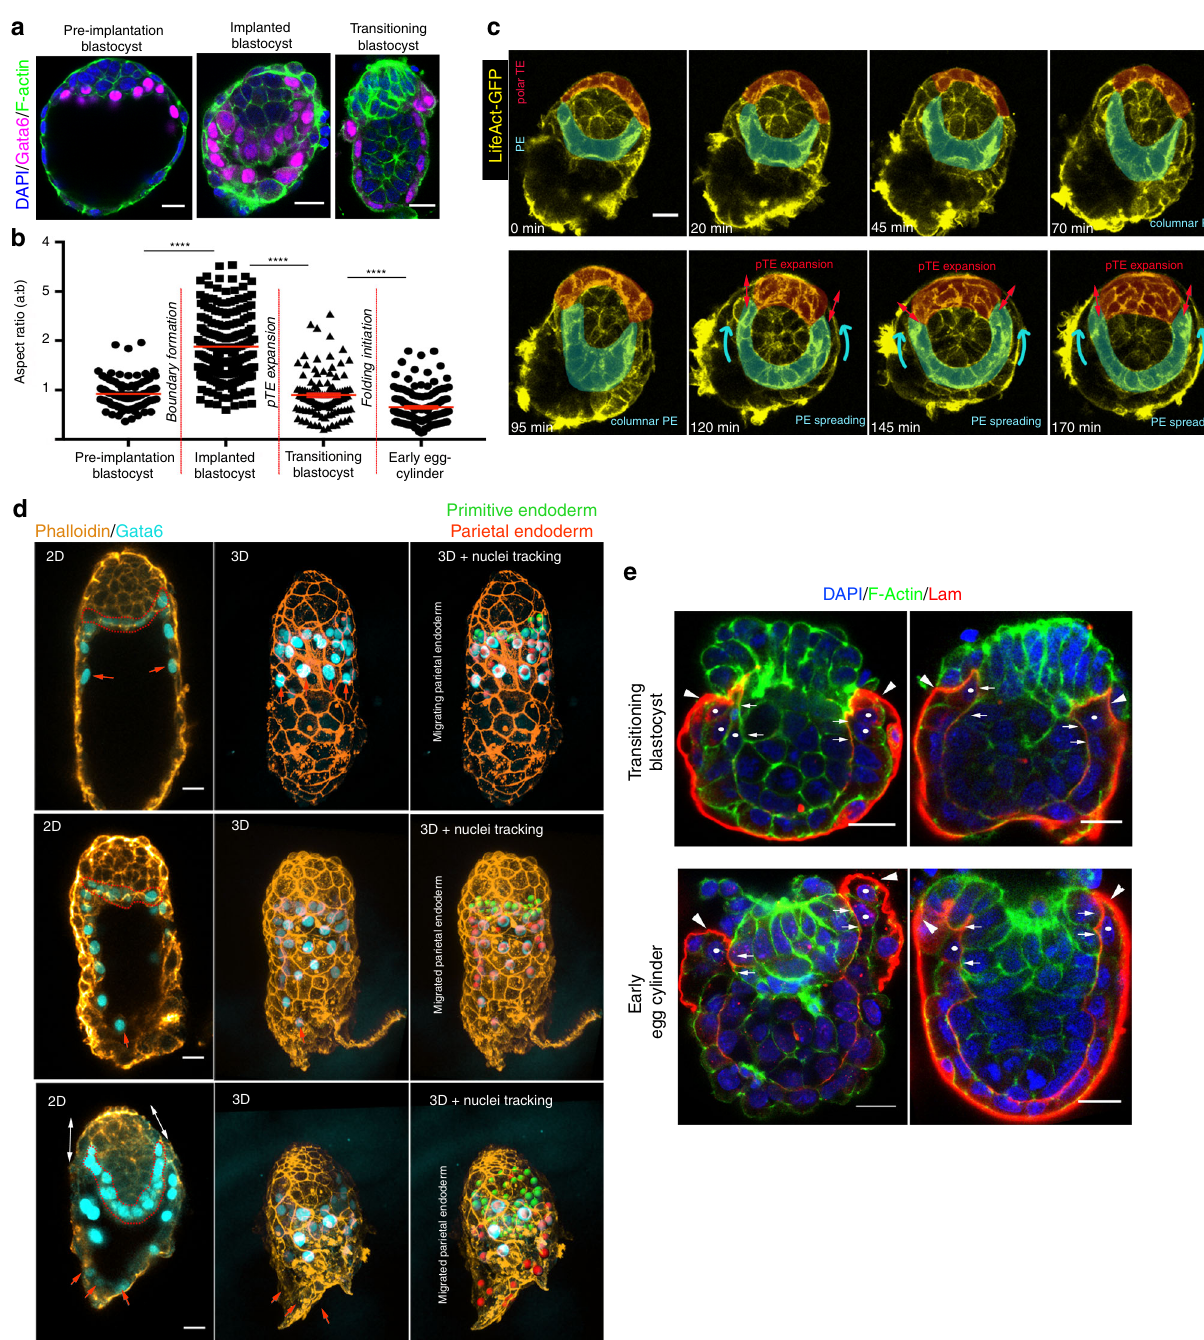
Fig. 5 Primitive endoderm behaviour during the blastocyst to egg cylinder transition. a Examples of embryos used for analysis of primitive endoderm (PE) cell shape at different stages of peri-implantation development. Representative of 20 embryos for each stage. b Quanti fi cation of PE cell aspect ratio at different developmental stages. The red lines between different columns correspond to events taking place within the trophectoderm (TE). Two-sided unpaired student ’ s t test; **** P < 0.0001; mean ± SEM. Pre-implantation blastocyst: n = 117 cells; Implanted blastocyst: n = 219 cells; Transitioning blastocyst: n = 117 cells; early egg cylinder: n = 184 cells. c Stills from a time lapse movie of Lifeact-GFP E4.5-implanting blastocyst. PE (cyan) acquires a columnar morphology at implantation stages and this is followed by tissue spreading through cell-shape changes upon polar TE (red) expansion as quanti fi ed in b . Red double-headed arrows: polar TE expansion. Cyan arrows: PE spreading. Stills without coloured overlay are presented in Supplementary Fig. 7b. d Representative examples of implanting blastocyst (E4.5 – E4.75). Parietal endoderm migration is completed before the expansion of the TE (double-headed arrows in bottom row) and before PE (red outline in 2D images) spreading over the lateral sides of the epiblast (bottom row). Red arrows indicate the front of the migrating parietal endoderm. e Representative examples of transitioning blastocysts (E5.0) displaying expanded polar trophectoderm and early egg cylinders. Primitive endoderm cells are found enclosed between the embryonic and Reichert ’ s basement membrane during blastocyst to egg cylinder transformation. arrowheads: Reichert ’ s membrane. Arrows: embryonic basement membrane. Dots: proximal cells. Representative images of 20 embryos per stage. Source data are provided as a Source Data fi le. Scale bars = 20 µ